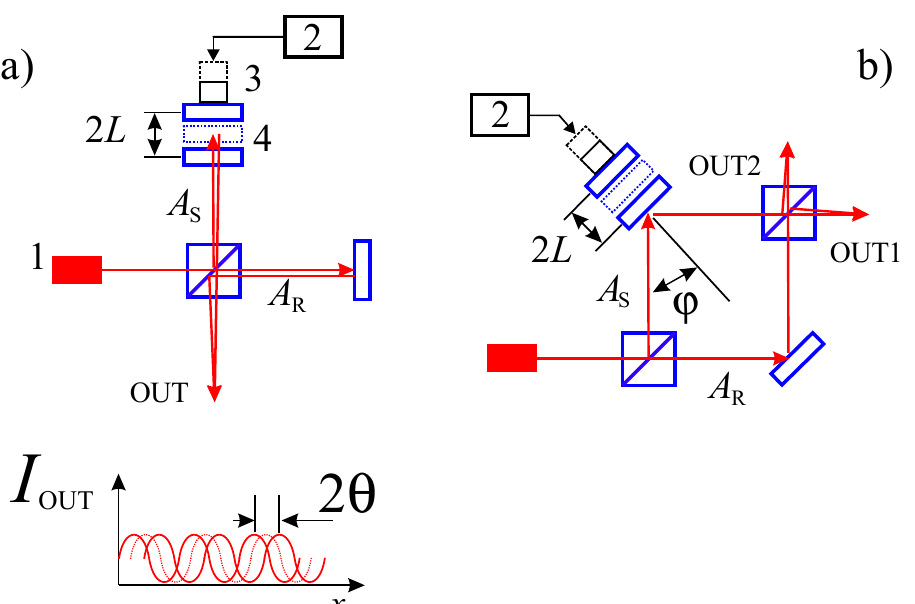
Figure 3. The two most commonly used schemes are the Michelson interferometer ( a ), and the Mach–Zehnder interferometer ( b ), 1—laser, 2—control voltage unit, 3—piezoactuator. The shift of the mirror (4) by an amount of L (shift amout) leads to a shift in the interference pattern on θ (phase shift), where θ = (4 π L / λ )cos ϕ , I OUT —dependence intensity on phase, A R —reference wave, A S —signal wave.